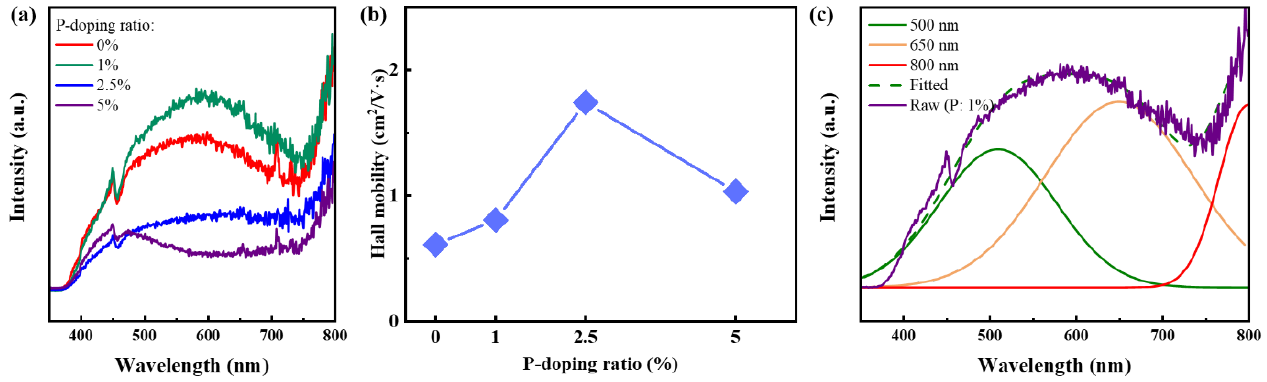
Figure 2. ( a ) PL spectra of Si NCs/SiC multilayers with various P-doping ratios; ( b ) Hall mobility of Si NCs/SiC multilayers with various P-doping ratios; ( c ) fitted PL spectra of 1% P-doped Si NCs/SiC multilayers.